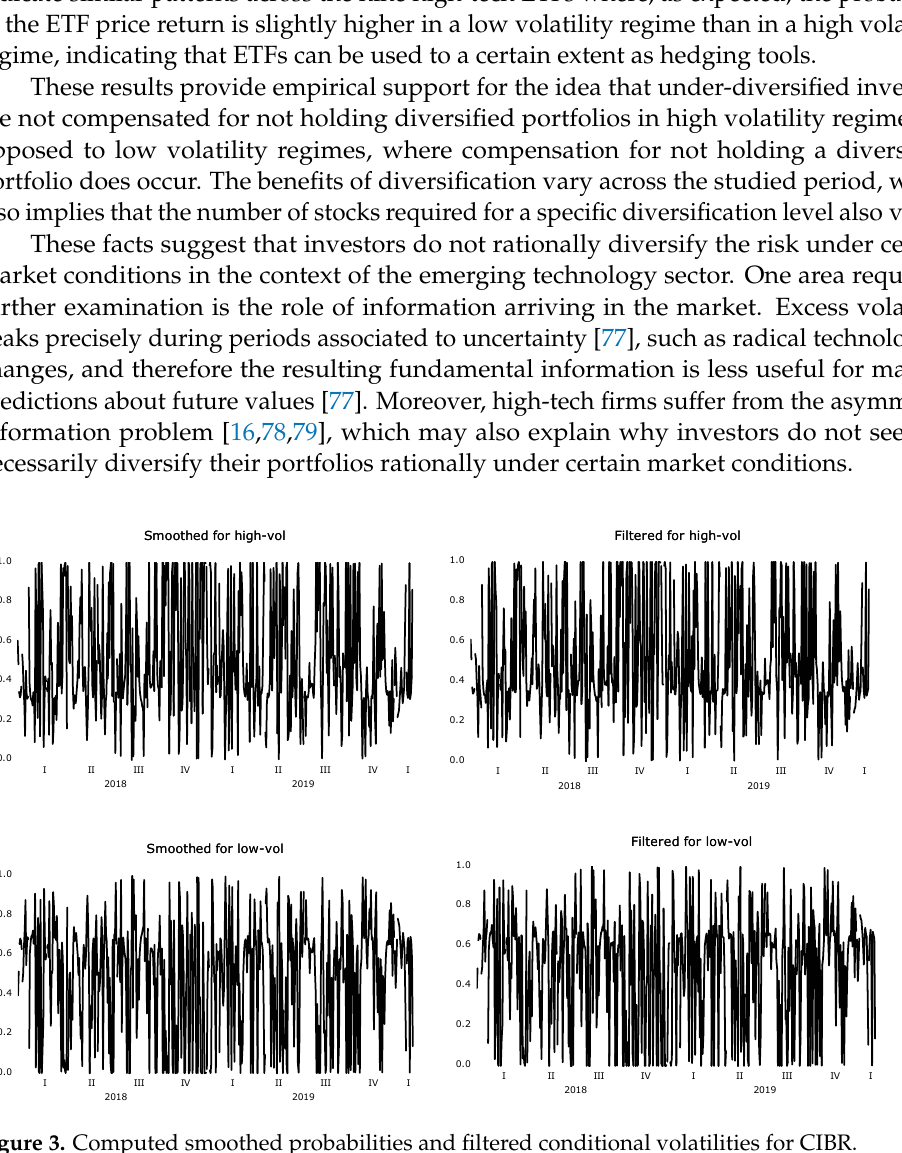
Figure 3. Computed smoothed probabilities and filtered conditional volatilities for CIBR.